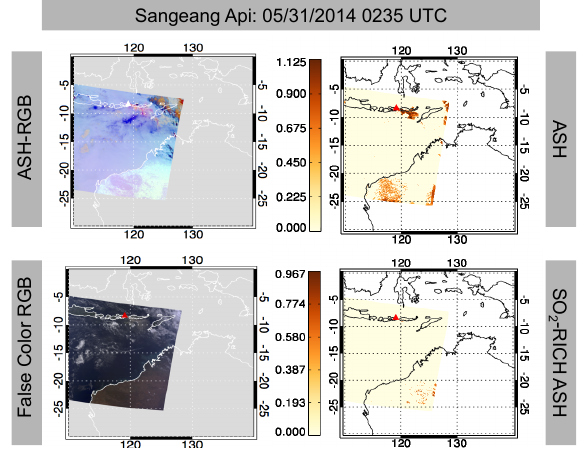
Figure 4. (Top left) Ash-RGB created using MODIS infrared bands 32–31, 31–29, and 31 for the eruption of Sangeang Api, 31 May 2014, 0235Z; (bottom left) false color RGB image cre- ated using MODIS reflective bands 1, 4, and 3 for the same erup- tion and time; (top right) ash-detection neural network output for the same eruption and time; (bottom right) SO 2 -rich-ash-detection neural network output for the same eruption and